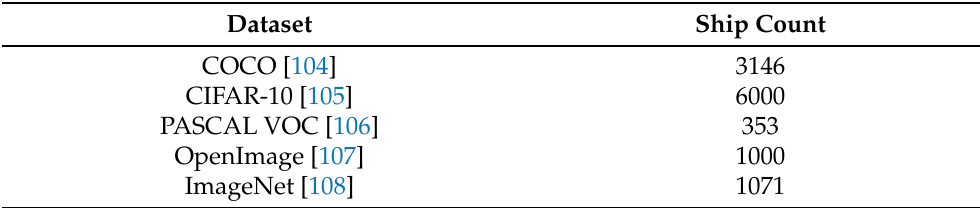
Table 2. Generic datasets.